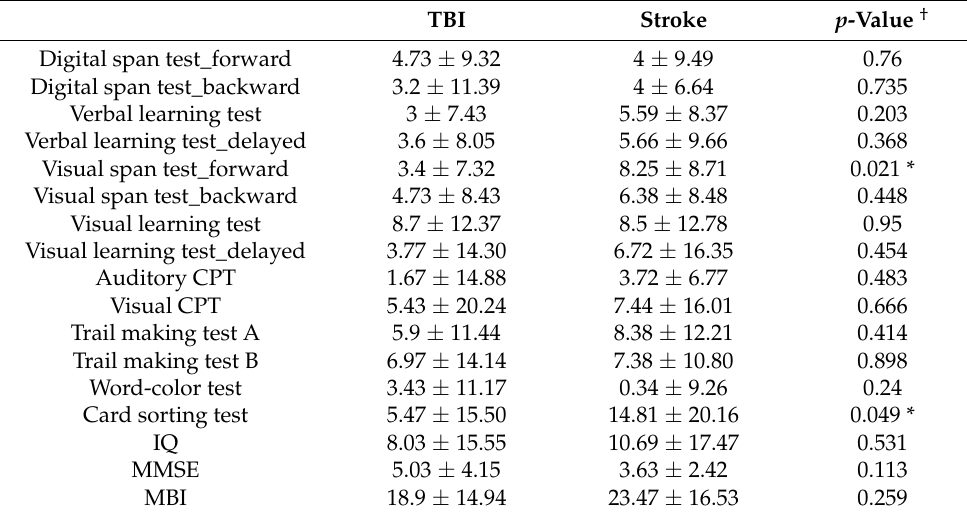
Table 3. Comparison between the TBI and stroke groups on difference values at pre- and post- cognitive